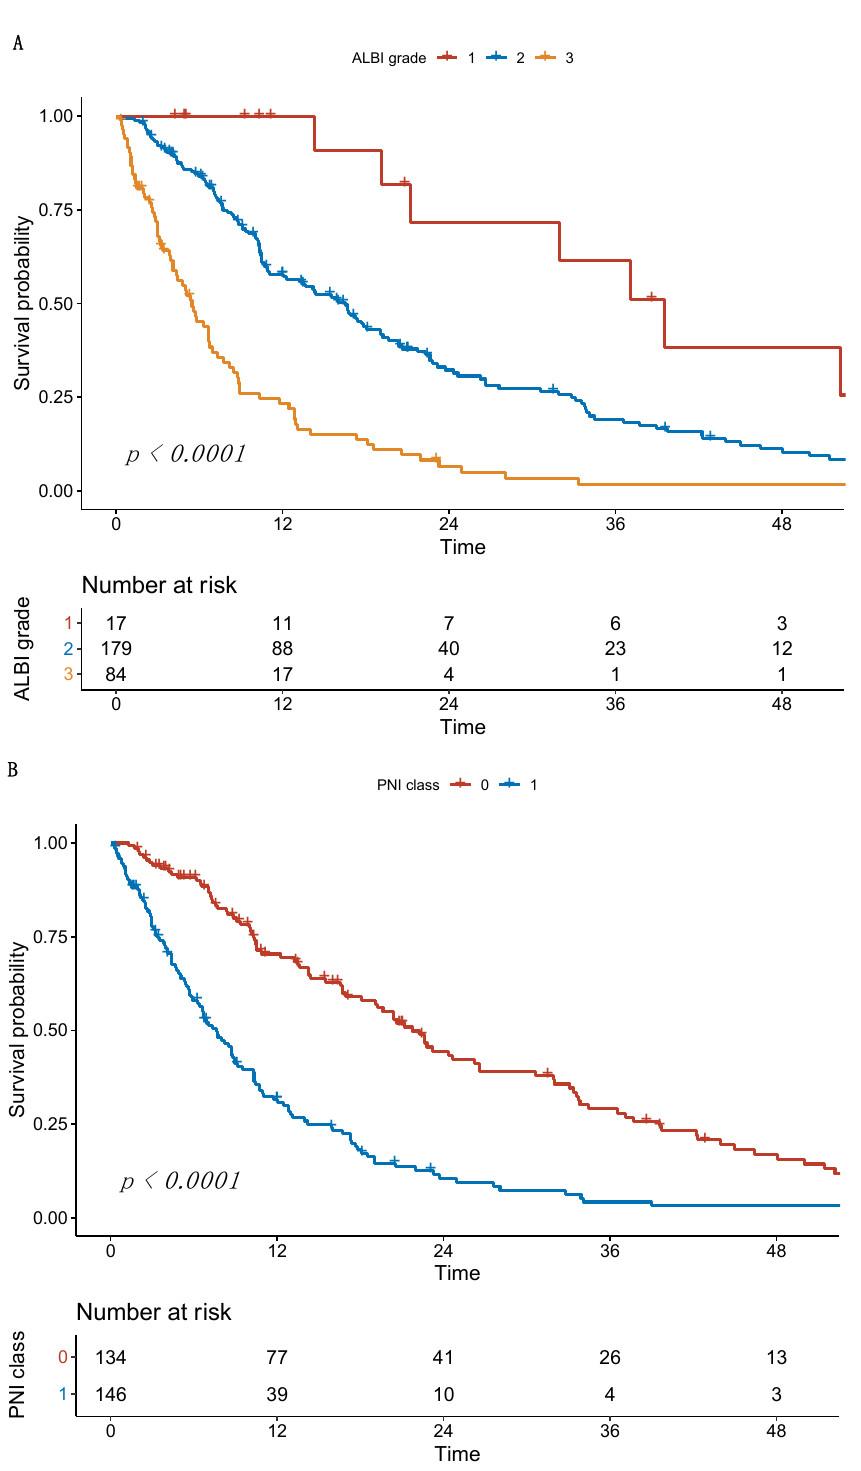
Figure 3. Kaplan–Meier curves of overall survival stratified according to ( A ) the ALBI grade and ( B ) the PNI.